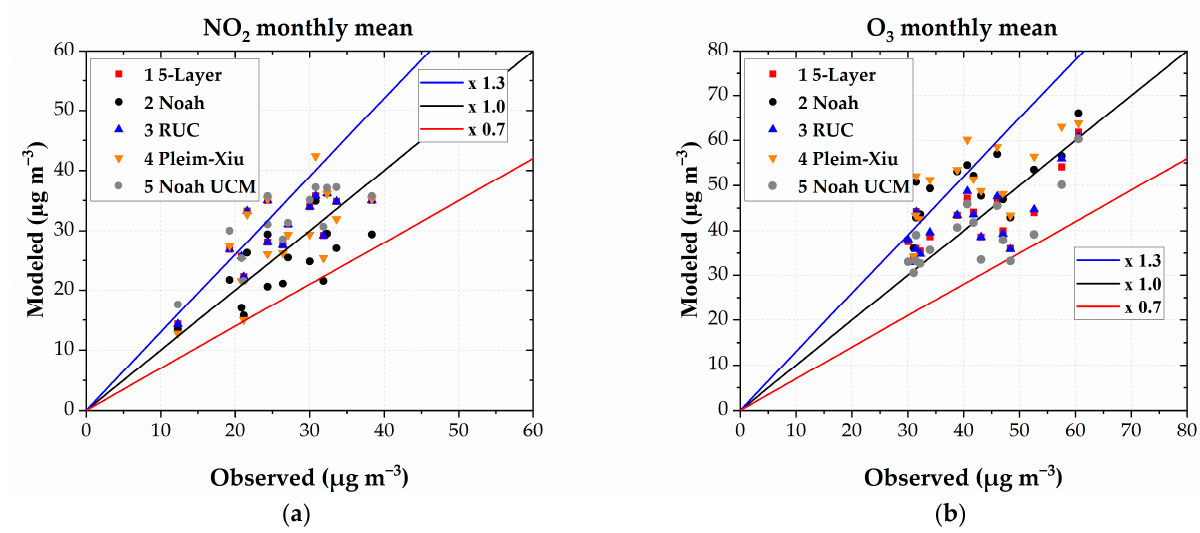
Figure 9. Passive stations: Observed versus modeled monthly means: ( a ) NO 2 and ( b ) O 3